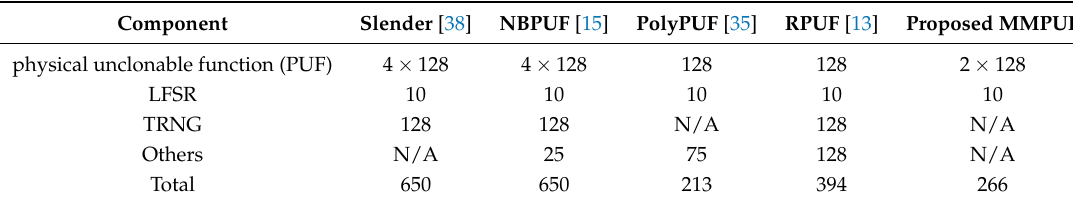
Table 4. Hardware Resource Comparison of the Primary Security